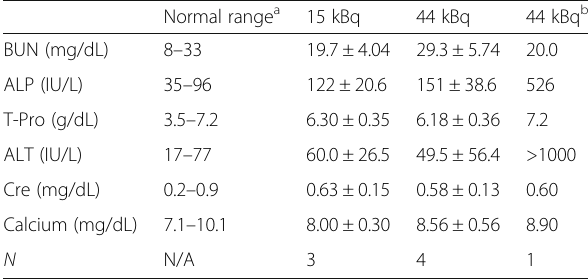
Table 3 Blood chemistries of non-tumor-bearing neu -N mice treated with 15 and 44 kBq of 225 Ac-DOTA-anti-PD-L1 (3 mg/kg, 60 μ